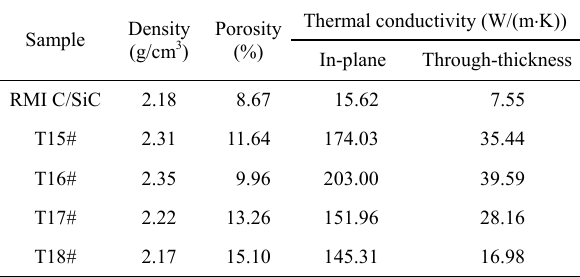
Table 2 Properties of C pf /SiC composites at different siliconization